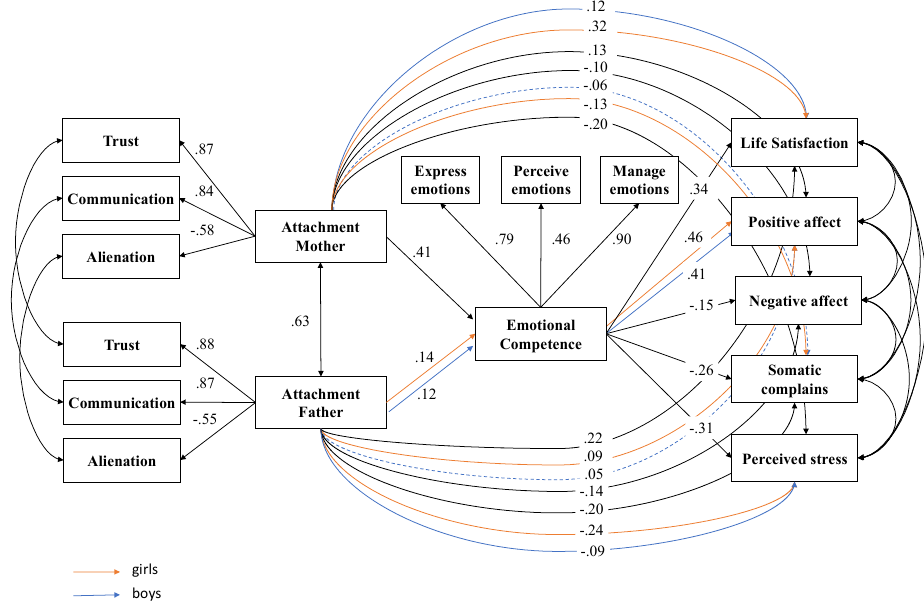
ff erences. Note: Significant e ff ects shown as standardized Figure 2. Multi-group path model: Sex differences. Figure 2. Multi-group path model: Sex di coe ffi cients ( β ); continuous pathways are significant at p < 0.01; dotted pathways are not significant; factor loadings are